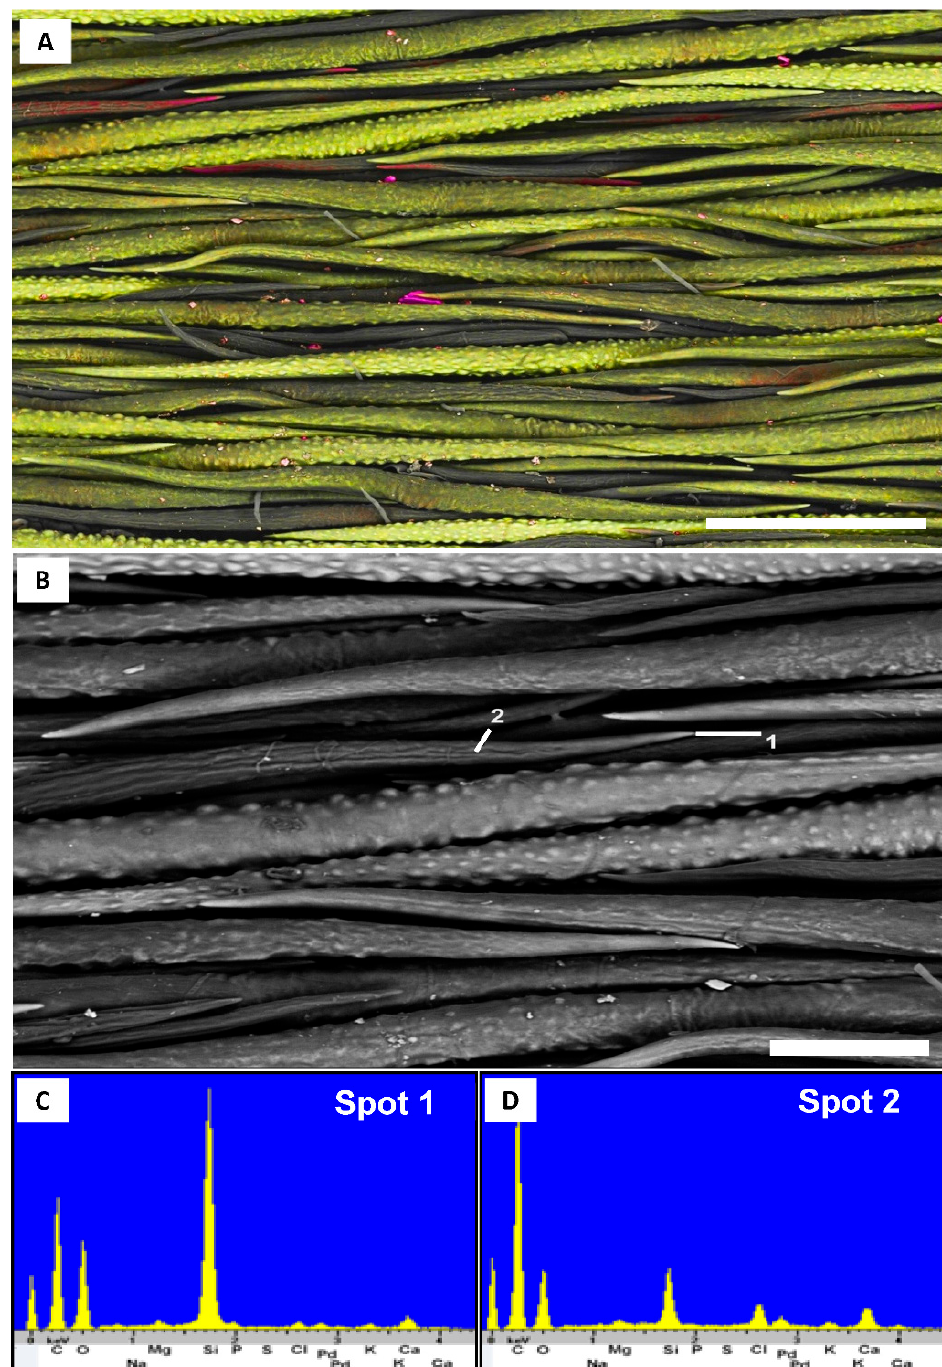
Figure 5. Silicium in Bornmuellera tymphaea ( Selvi & Bettarini , FI-055791, FI). ( A ). Topographic (secondary electron) image combined with element mapping images of Si (red) and Ca (yellow) shows distribution of Si primarily in the tip but also in the body. ( B ). Secondary electron image with analyzed spots associated with energy-dispersive X-ray spectroscopy spectra labeled. ( C ). Energy-dispersive X-ray spectroscopy spectra of spot 1 (tip). ( D ). Energy-dispersive X-ray spectroscopy spectra of spot 2 (shaft). Energy-dispersive X-ray spectroscopy spectra depict the concentration of Si in relation to other elements present. Scale bars: ( A ), 200 µ m; ( B ), 70 µ